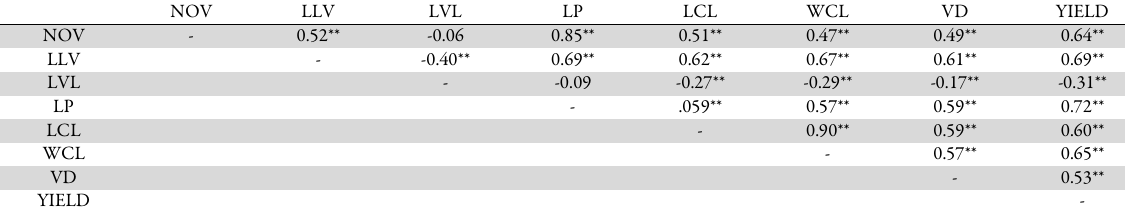
Table 1. Correlation coefficients among eight selected traits of T. occidentalis NOV LLV